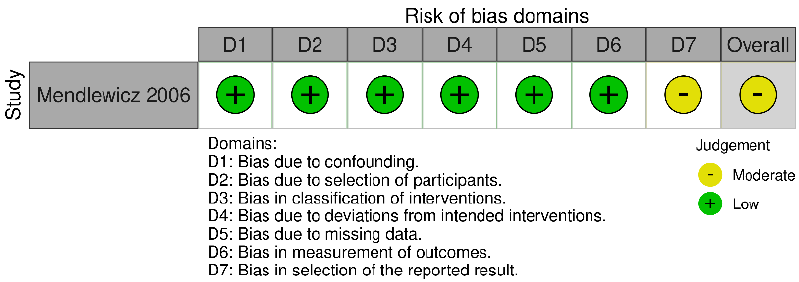
Figure 3. Risk of bias for interventional randomized studies separately and summarizing with Rob2 tool.